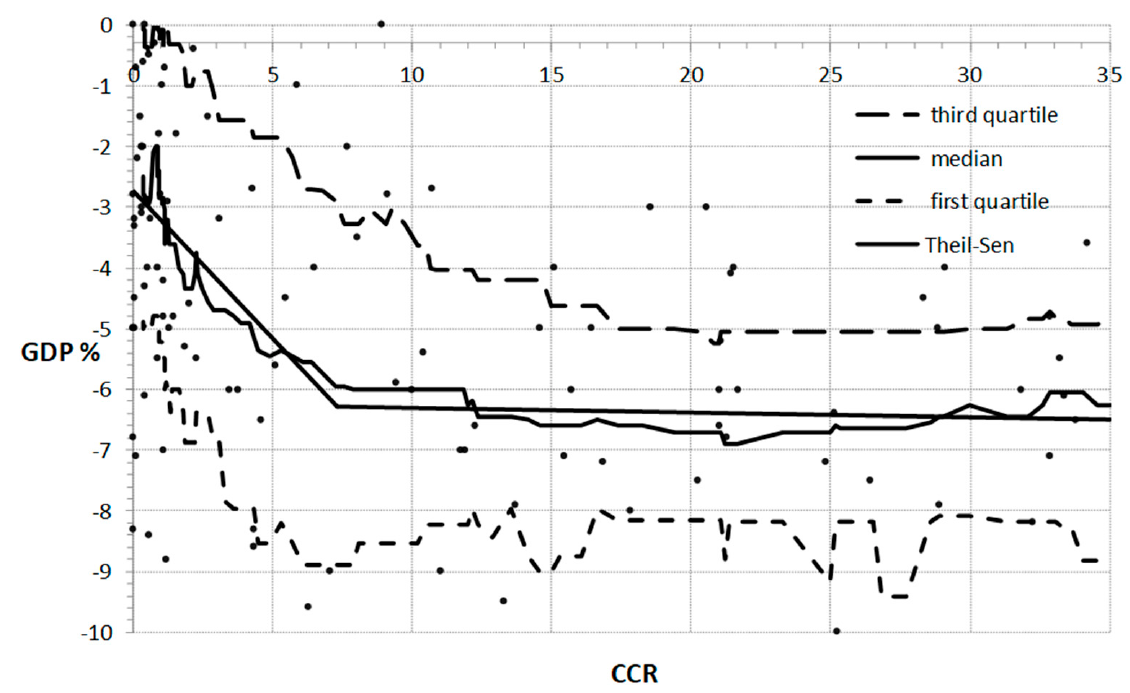
Figure 1. The relation between CCR and GDP with the moving median, first and third quartiles, and two-segment linear Theil–Sen approximation.